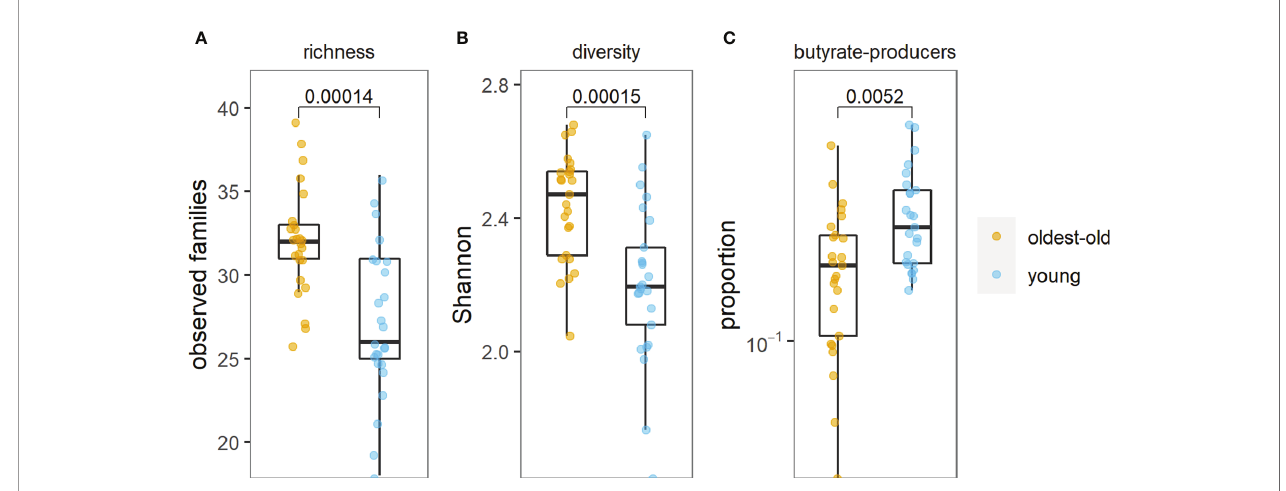
FIGURE 1 | Richness of microbiota (A) , diversity of microbiota (B) , and abundance of butyrate-producing bacteria (C) in the oldest-old and young groups.